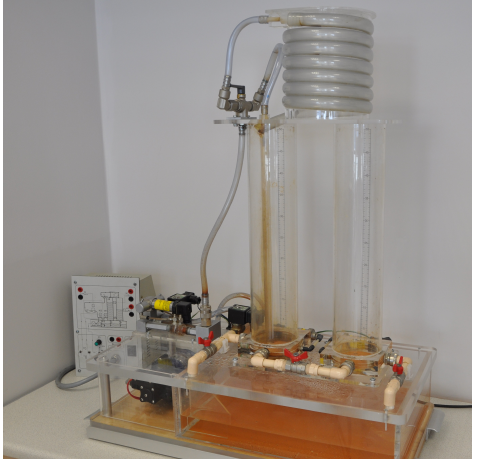
Figure 12. Two-tank system.